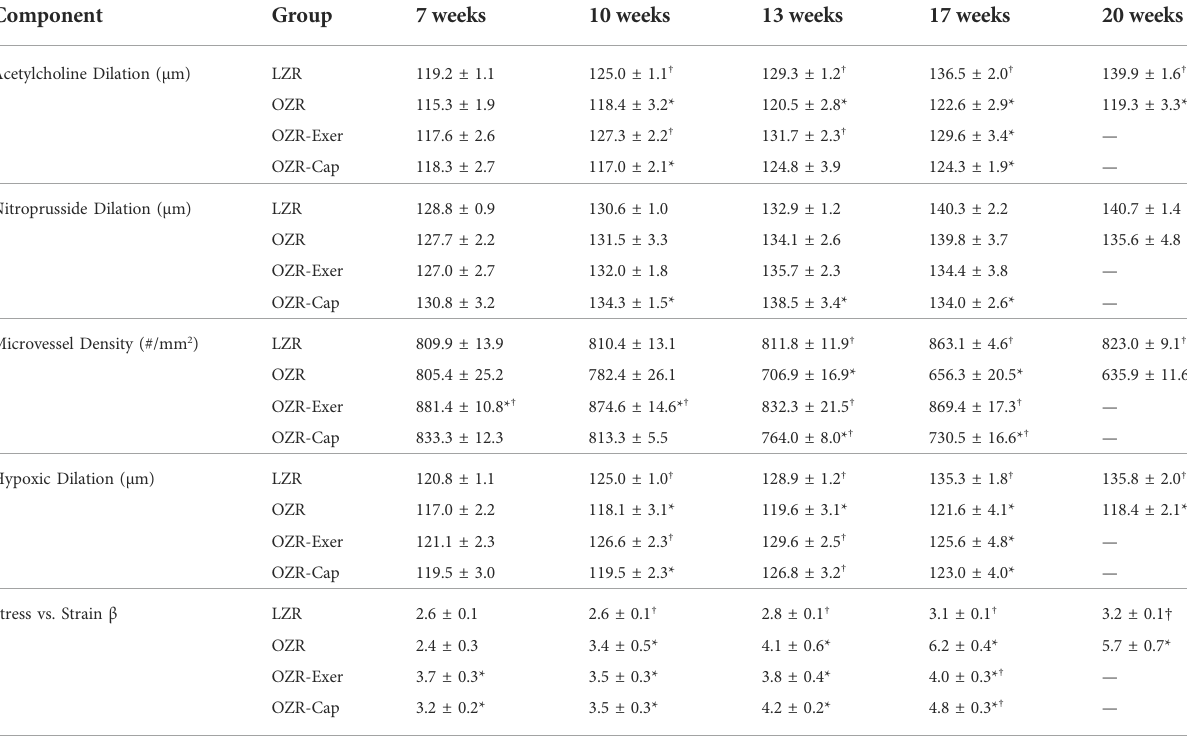
TABLE 4 Peripheral (skeletal muscle) vascular component data, presented as mean ± SE, for the animal groups of the present study across all age.